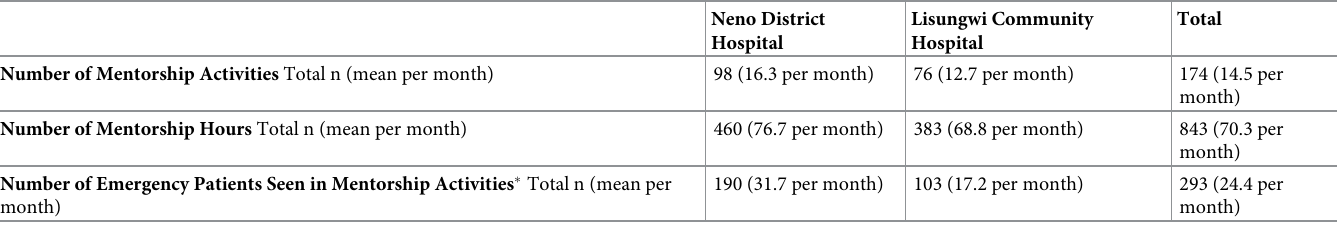
Table 4. Total number of mentorship activities, hours of mentorship and number of emergency